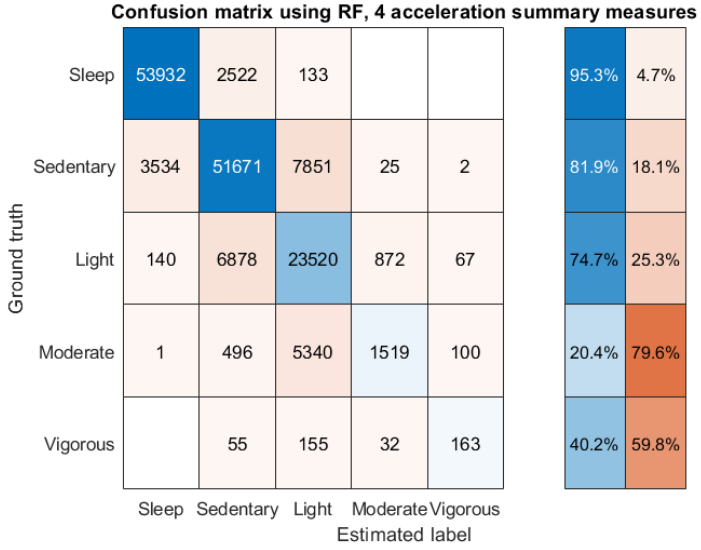
Figure 5. Minute-wise confusion matrix to estimate the five categories (sleep; sedentary, light, moderate, and vigorous PA) by using the optimized thresholds independently for each of the four acceleration summary measures and presenting their outputs (estimated categories) as inputs to an RF. On the right-hand side, we have the percentage of correctly vs. incorrectly matched labels for each of the five categories. Overall accuracy: 82.2%. The results refer to out-of-sample performance and were computed by using the leave-one-participant-out approach, wherein we collated all outputs in a single confusion